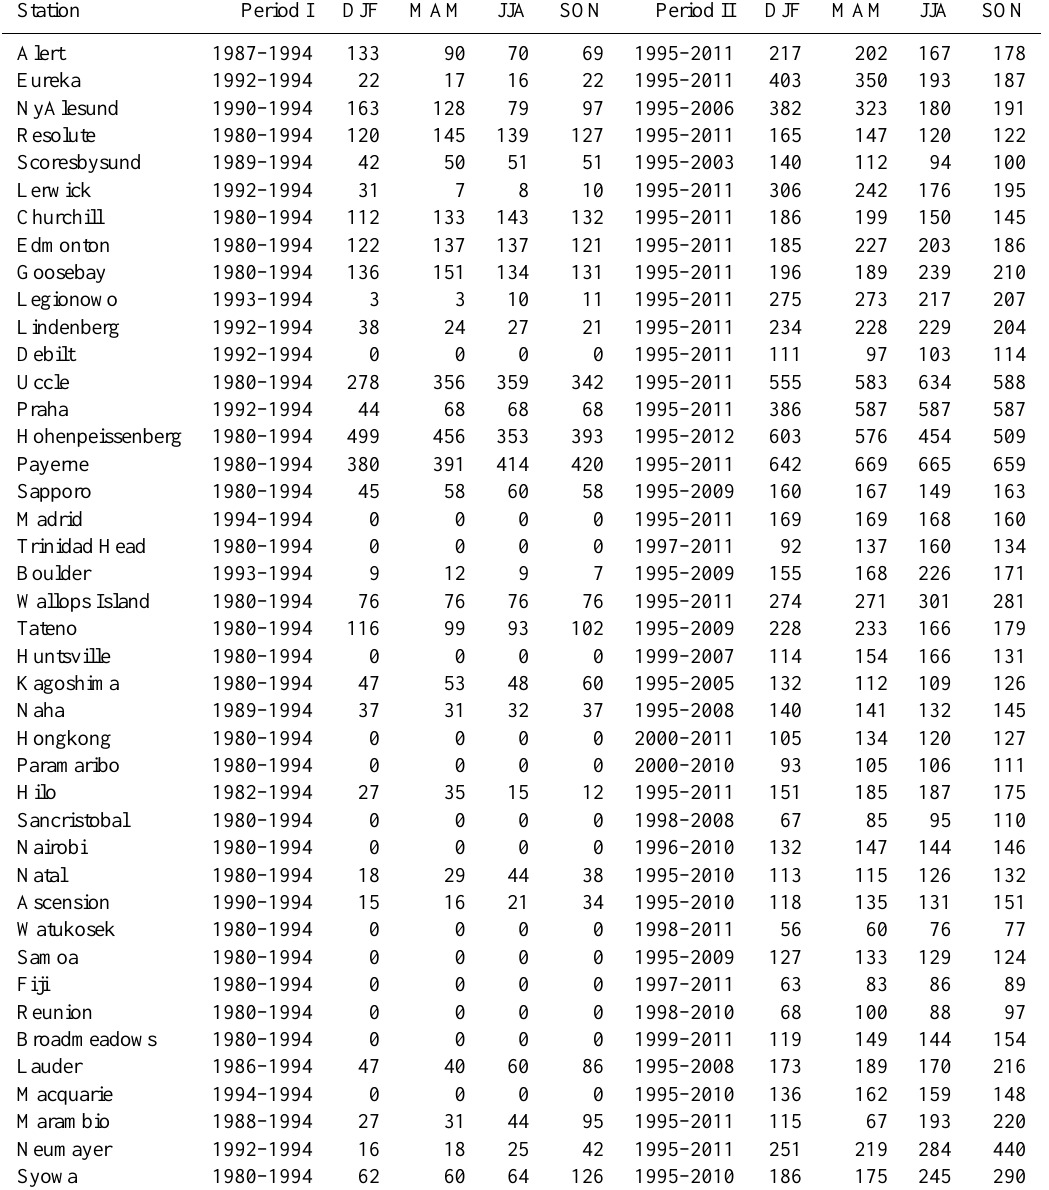
Table 1. Number ozone profiles per season and period considered, Period I: 1980–1994, Period II: 1995–2011.